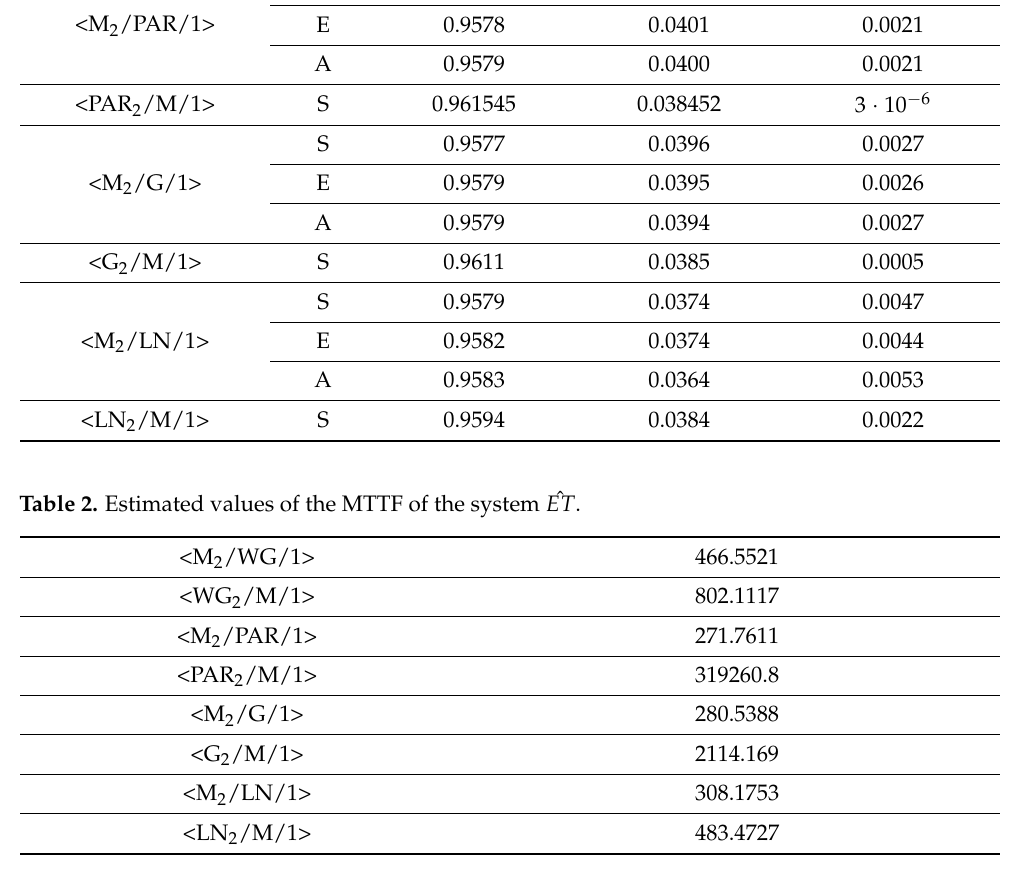
Table 3. Relative estimation error (Re) of the time to failure of the system.